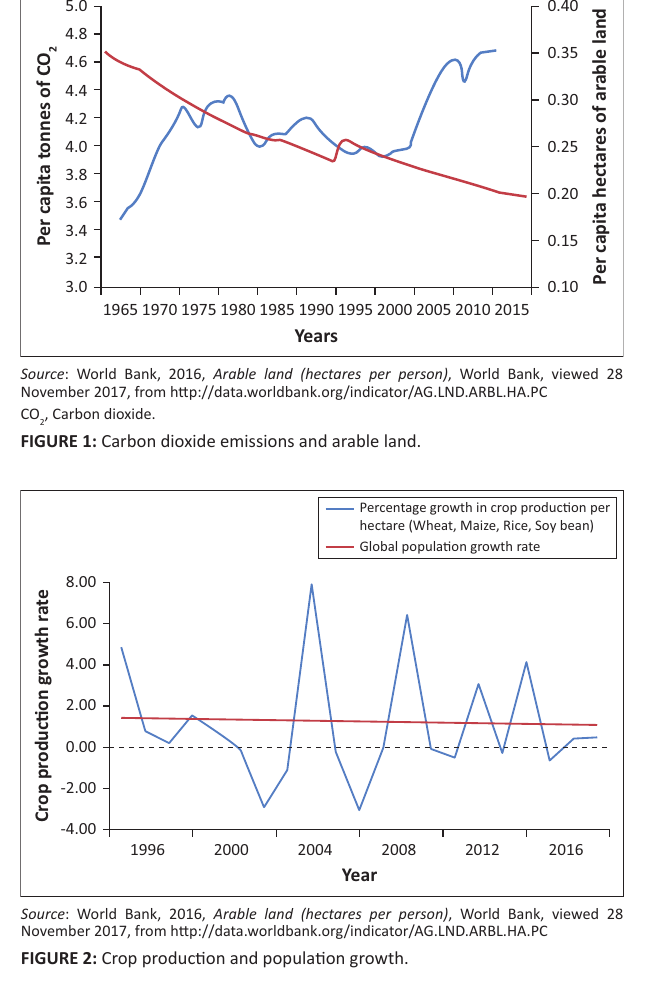
FIGURE 2: Crop production and population growth.